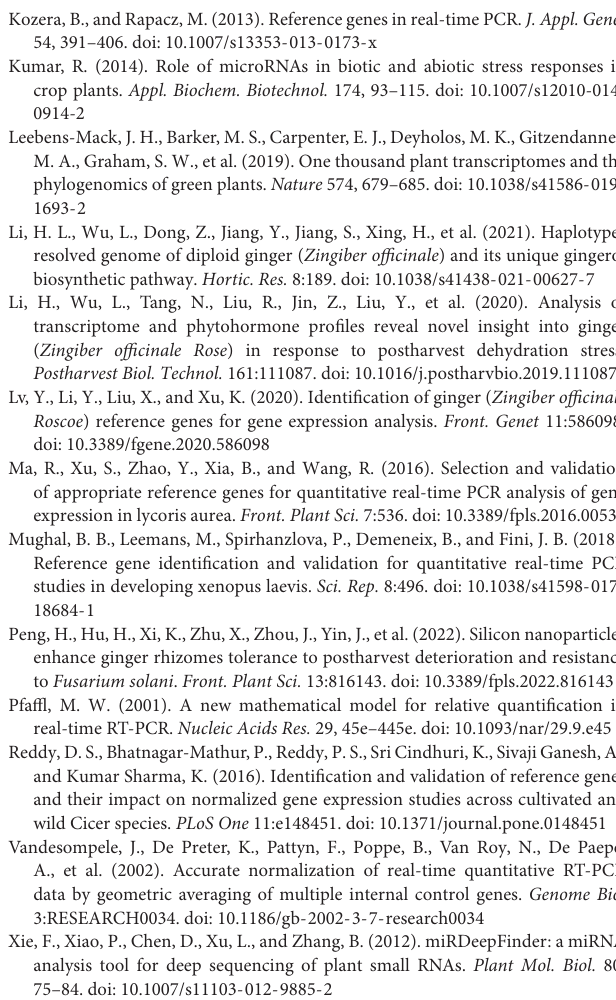
Supplementary Table 1 | FPKM candidate. Supplementary Table 2 | Blast candidate. Supplementary Table 3 | FPKM annotation candidate. Supplementary Table 4 | Candidate primer information. Supplementary Table 5 | Fengtoujiang Cq values. Supplementary Table 6 | Other cultivars Cq values. Supplementary Table 7 | PR and MYB primer information. Supplementary Table 8 | PR and MYB Cq